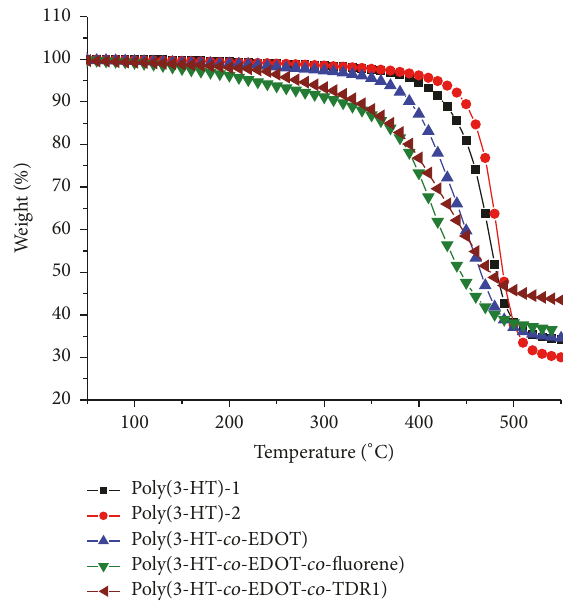
Figure 4: Thermograms for the